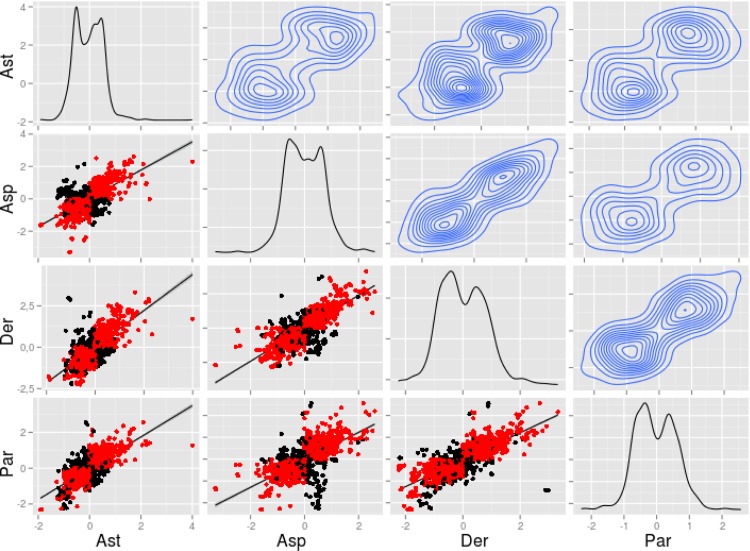
Eosinophils from asthmatic subjects display a similar transcriptional profile as eosinophils from other hypereosinophilic conditions.Scatterplots are based on fold changes of selected genes that are differentially expressed at least in one hypereosinophilic disease (p< 0.01). Diagonal: estimation of the density of log fold changes (lfc) for each variable. Upper elements: estimation of the bivariate density of each couple of variables. In red: genes with a lfc changed to the same direction in all the conditions. In black: genes with a lfc changed to the opposite direction in at least one couple of variables. With a cut-off for the lfc of 0.15, more than 95% of the probe sets have identical changes. Ast, asthma; Asp, pulmonary aspergillosis; Der, dermatological disease; Par, parasitosis.